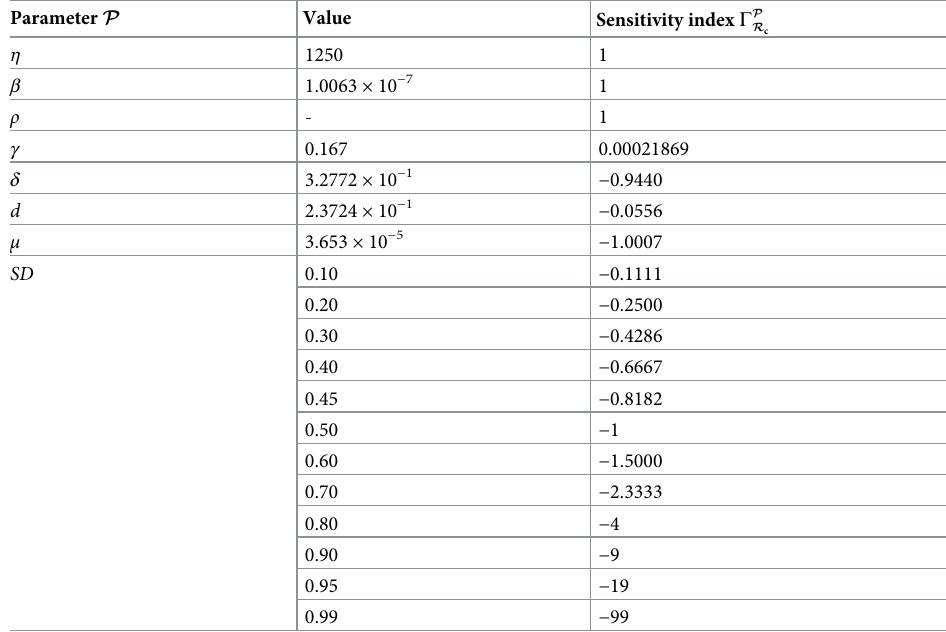
with respect to the parameters P of model c